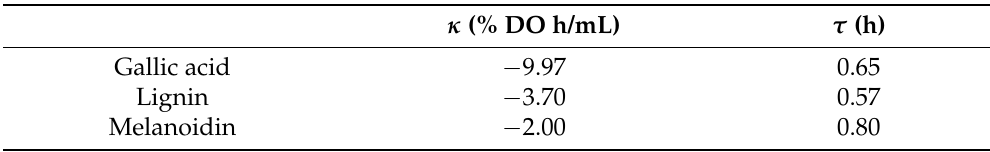
Table 3. Transfer function parameters in the Laplace domain for each RC obtained from OL experi- ment